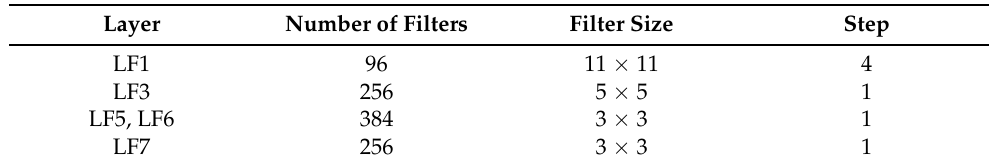
Table 1. Characteristics of convolutional layers for an experiment using face image as neural net- work inputs.